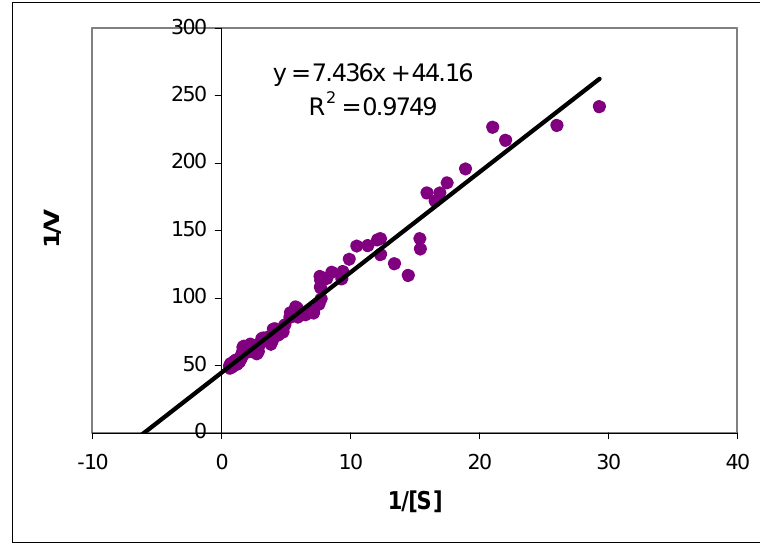
y = 7.436x + 44.16 R 2 =